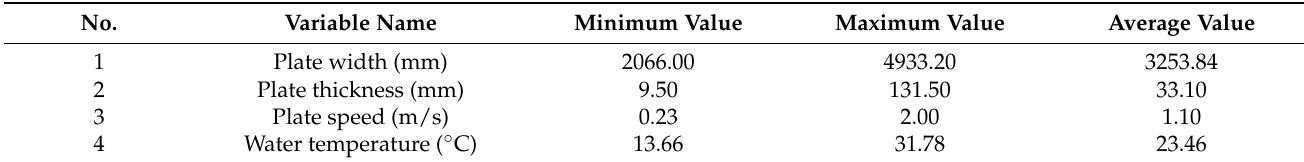
Table 1. Original data set